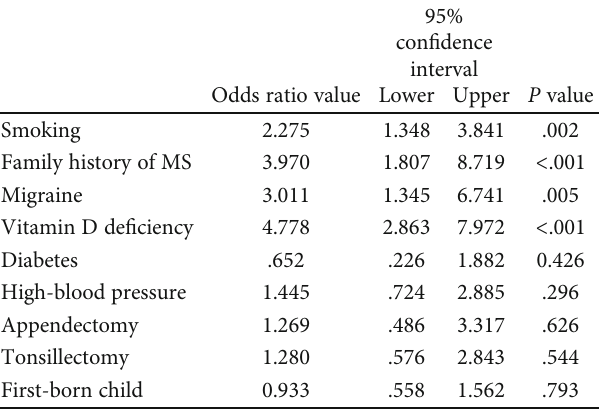
Table 3: Detailed comparison of the result values for each risk factor between the two